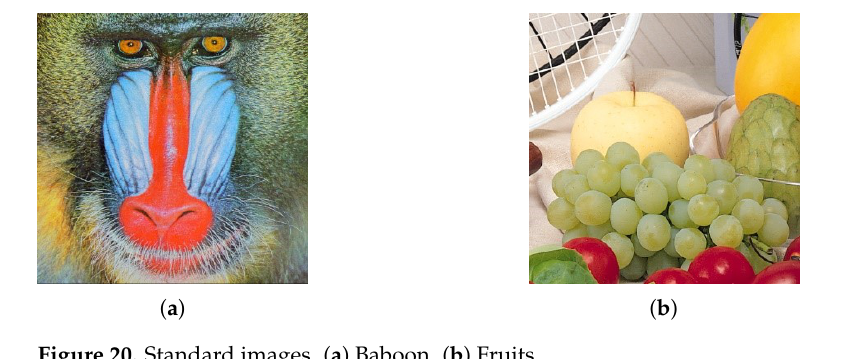
Figure 20. Standard images. ( a ) Baboon. ( b )